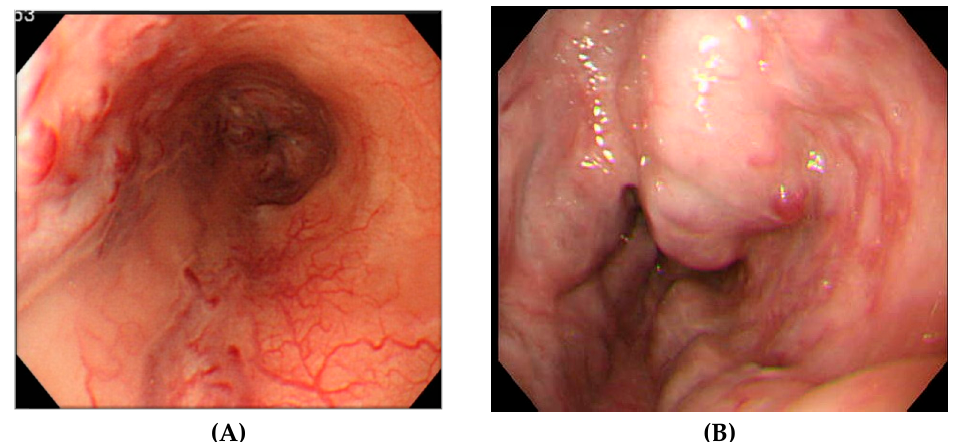
Figure 2. RC findings in esophageal varices. Cherry red spot (CRS) and red wale marking (RWM) ( A ). Two varices were found at 9 o ’ clock and 6 o ’ clock, respectively. Several reddened spots, which consisted of CRS, were found at 9 o ’ clock. Thin linear blood vessels, which consisted of RWM, were found at 6 o ’ clock. Hematocystic spot (HCS) ( B ). The varices found at 2 o ’ clock were thick and showed strong development. The thick blood vessel prominence, which is an HCS, is visible on the varices.